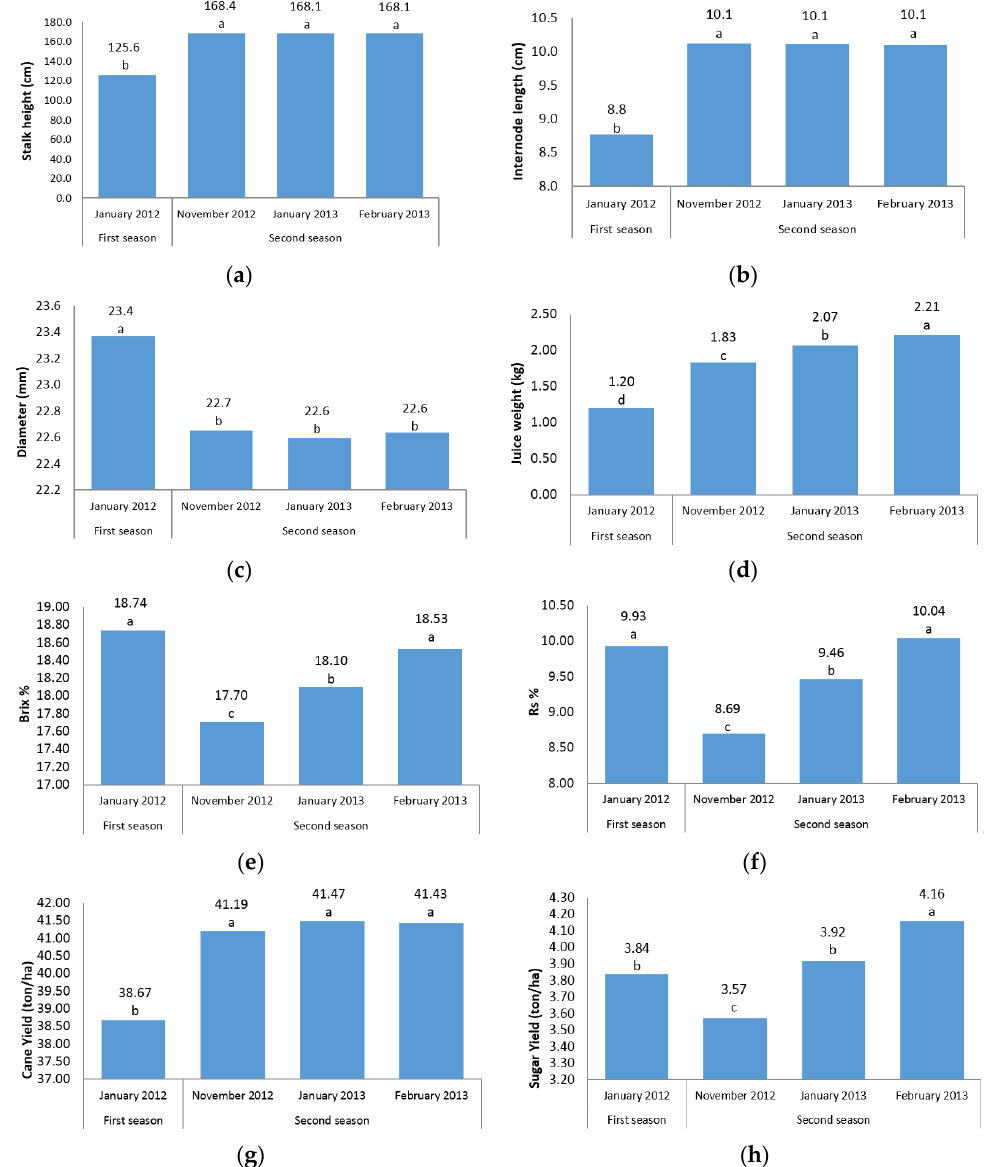
Figure 1. ( a ) Mean stalk height (cm); ( b ) Mean internode length (cm); ( c ) Mean diameter (mm); ( d ) Mean juice weight (kg); ( e ) Mean percentage Brix of juice extracted from stalks; ( f ) Mean recoverable sucrose; ( g ) Mean cane yield (ton/ha); and ( h ) Mean sugar yield (ton/ha) of primary collection of sugarcane accessions measured in two seasons (in four time points). In all Figures ( a – h ), means followed with the same letters are not significantly different at p ≤ 0.05.